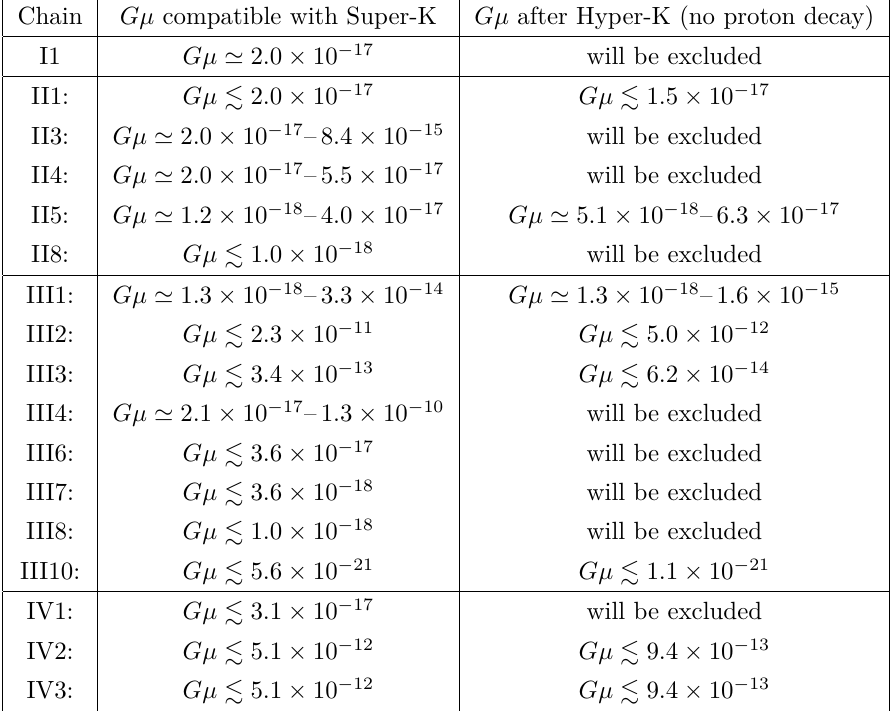
Table 6 . Breaking chains which generates observable GWs from cosmic strings and the predicted Gµ which are compatible with the Super-K bound and the future Hyper-K experiment limit on the proton decay lifetime (assuming no signal). Only breaking chains which have not been excluded are shown. For each breaking chain, the gauge unification connects intermediate scales with the GUT scale and gauge couplings. Super-K has set a lower bound on the proton life time τ > 1 . 6 × 10 34 π 0 e years and Hyper-K is expected to set a bound τ > 1 . 4 × 10 35 years, assuming no signal of proton π 0 e decay is observed. This information can be transformed bounds on Gµ , with RG running and gauge unification taken into